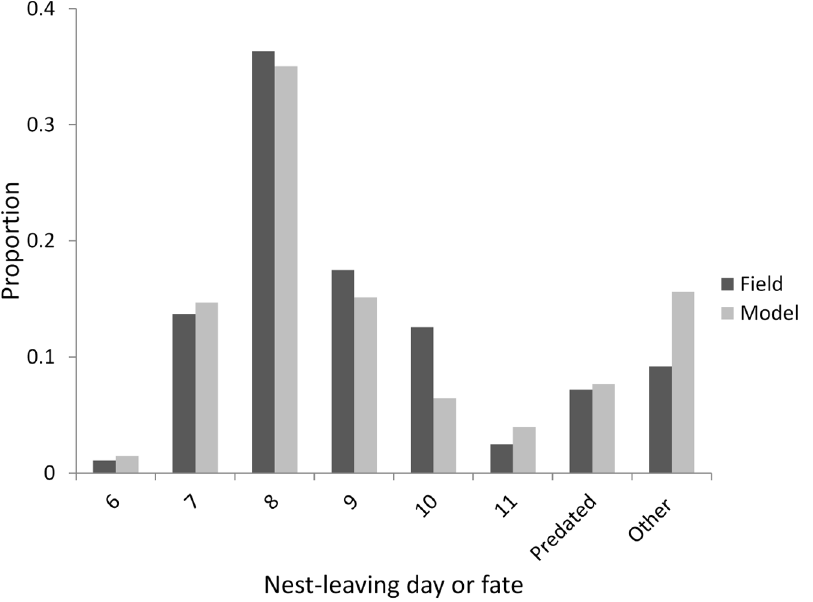
Figure 4. Comparison of the nest-leaving day of fledglings and causes of nestling mortality observed in the Kalø study area and those predicted by the ALMaSS skylark